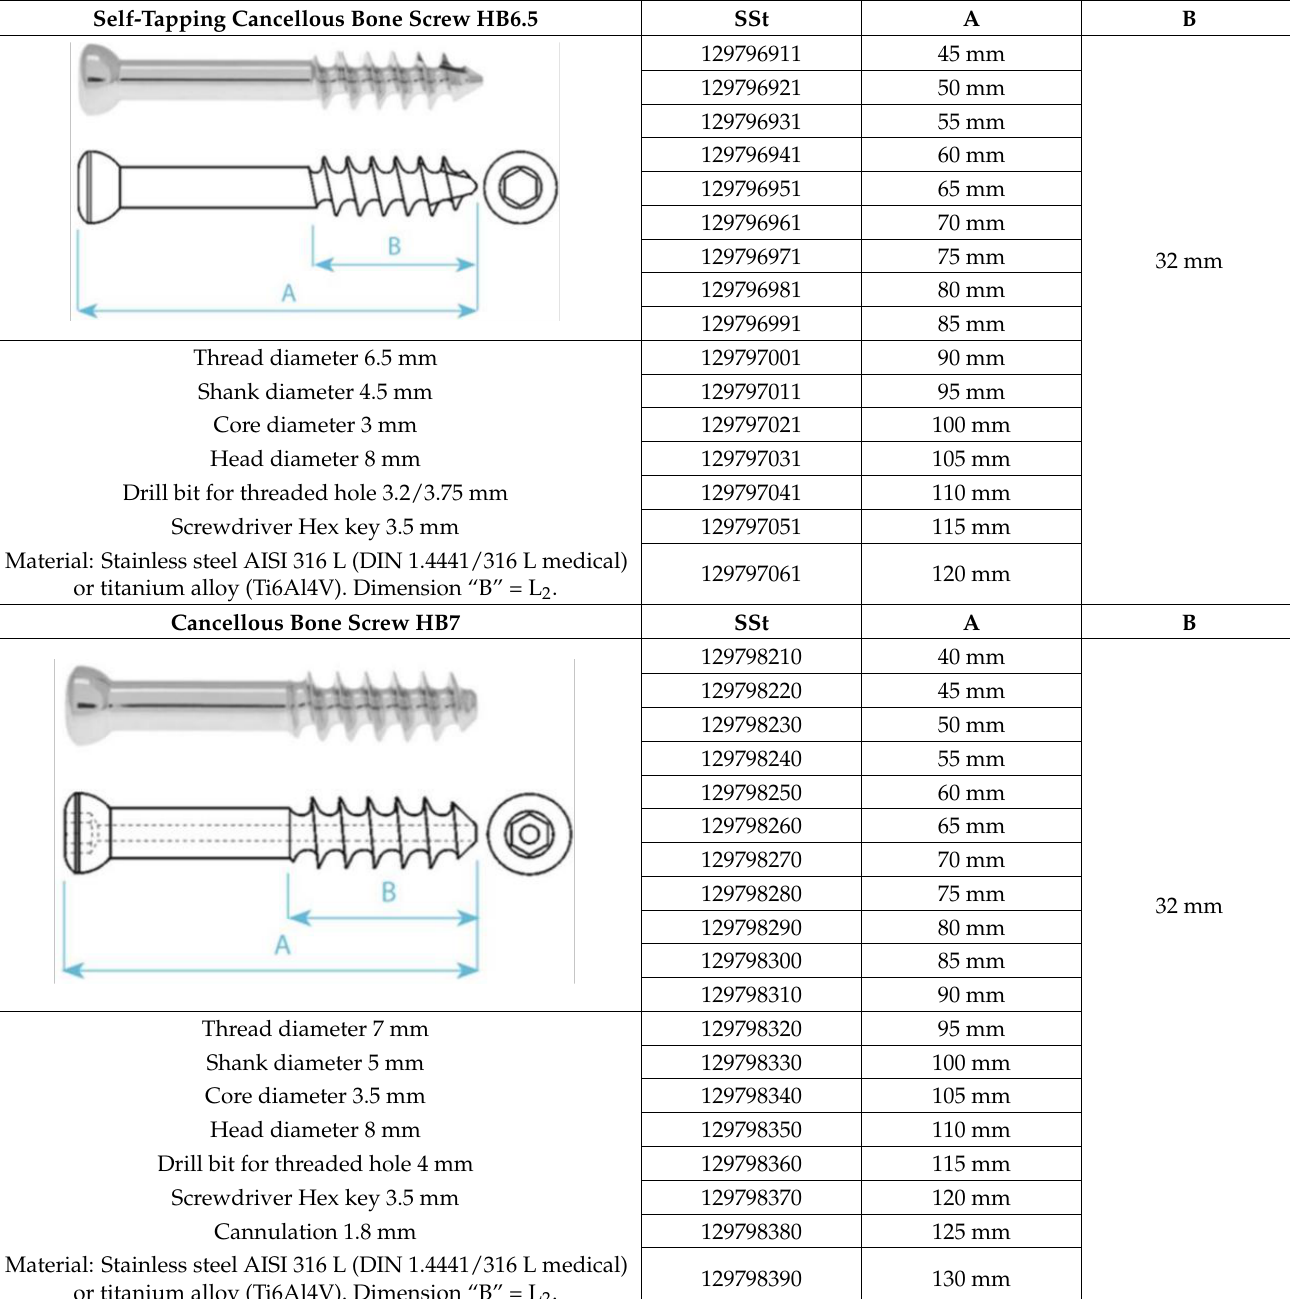
Table 2. Basic material information on the applied cancellous screws (see [20]). Self-Tapping Cancellous Bone Screw